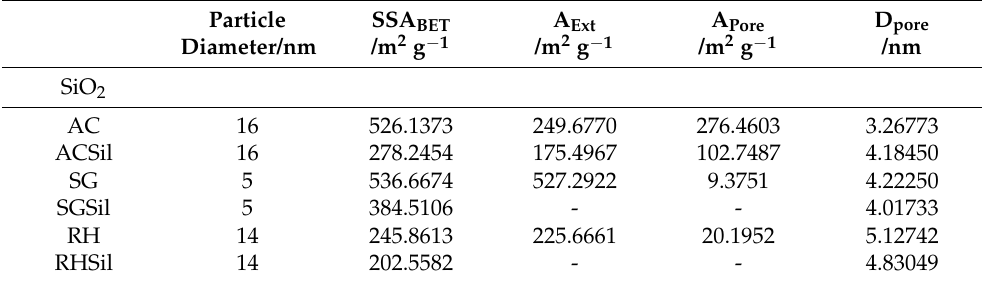
Table 1. N 2 adsorption/desorption results for the SiO 2 samples before and after